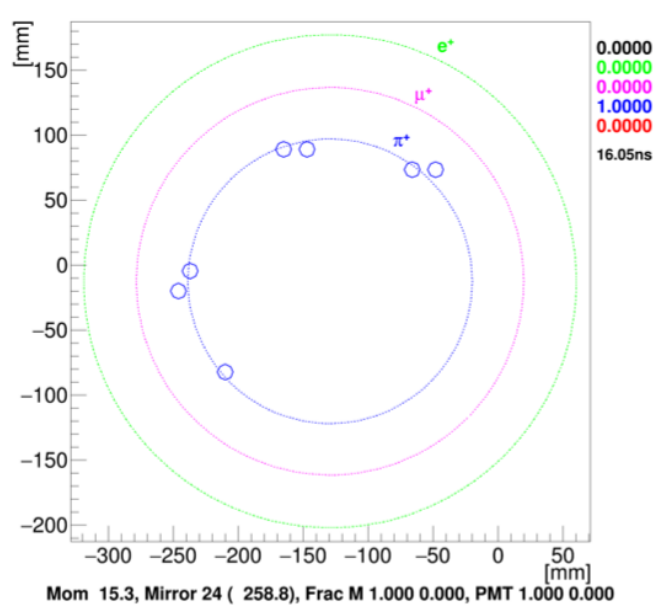
Figure 5. Position of the hits in the RICH forming the ring associated with the pion of the observed event in SR2, as given by the RICH event display. The circles illustrate the positron, muon, and pion hypotheses, showing a perfect agreement of the observed event with the pion